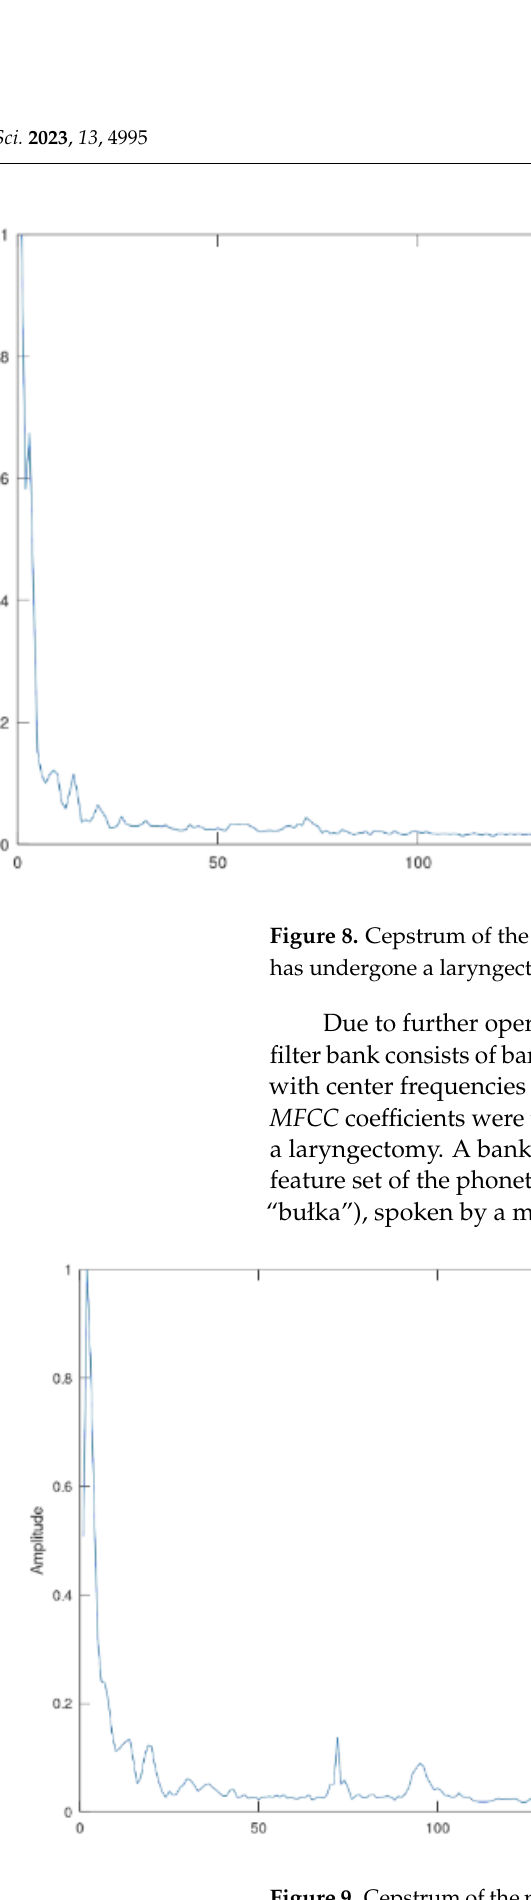
Figure 10. MFCC features of the Seg 1 (“buł”) of word bread roll (“bułka”)— man after laryngectomy. 3.Results The study included people who had had total laryngectomy surgery. The purpose of the research was to define feature vectors extracted from the time and frequency do- mains. Two analytical approaches and a number of descriptors were used to parameter- ize the analyzed phonetic segments. The following speech-signal descriptors used: •